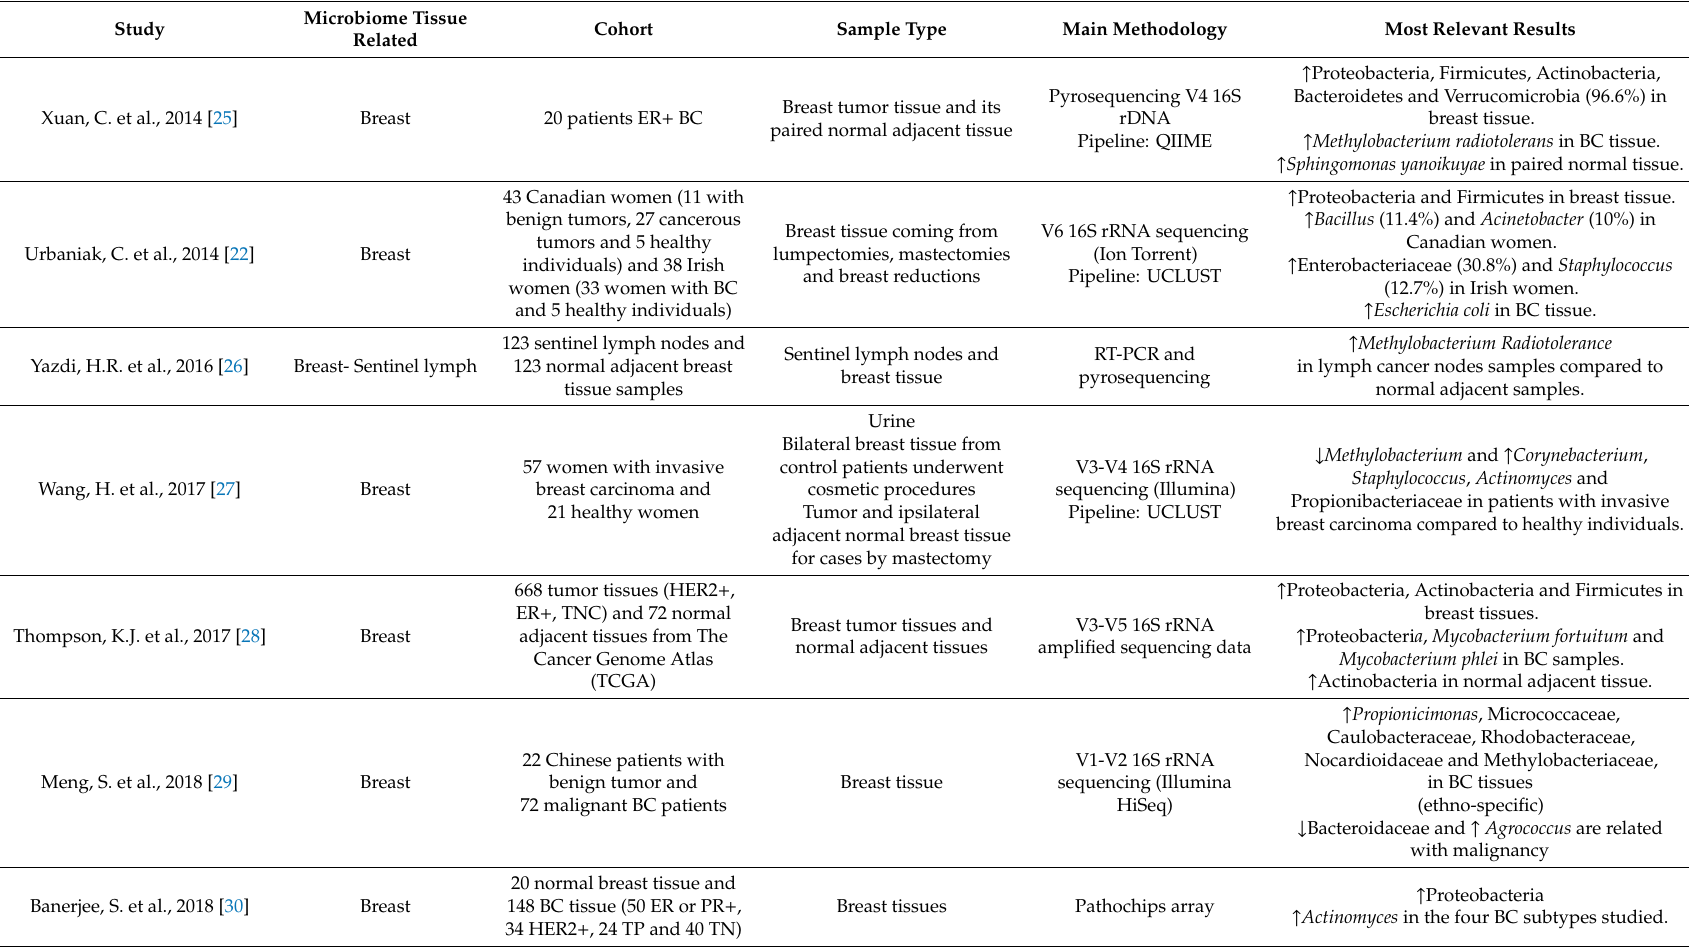
Table 1. Summary of studies addressing the association between breast cancer (BC) and breast-gut axis